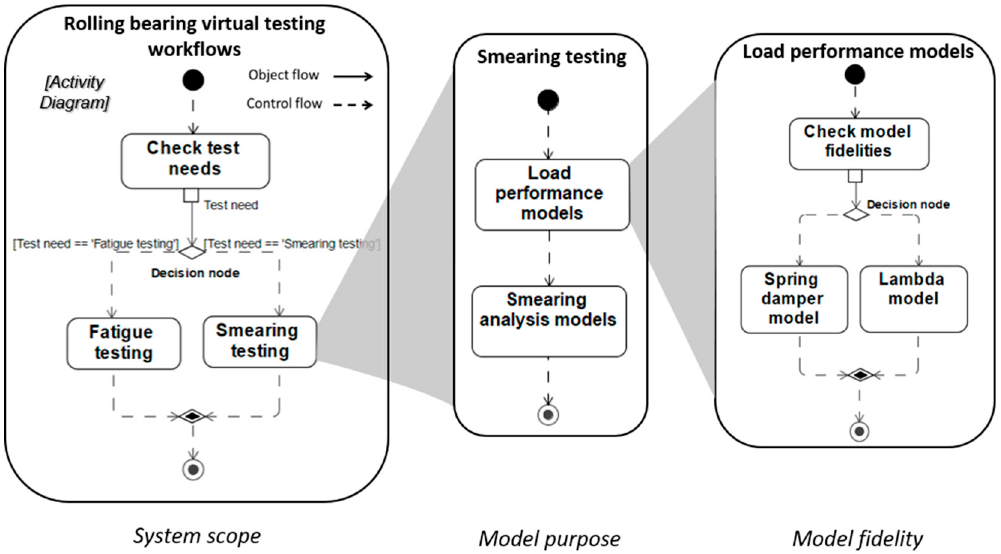
Figure 5. Nested virtual testing workflows based on the domain model classification.